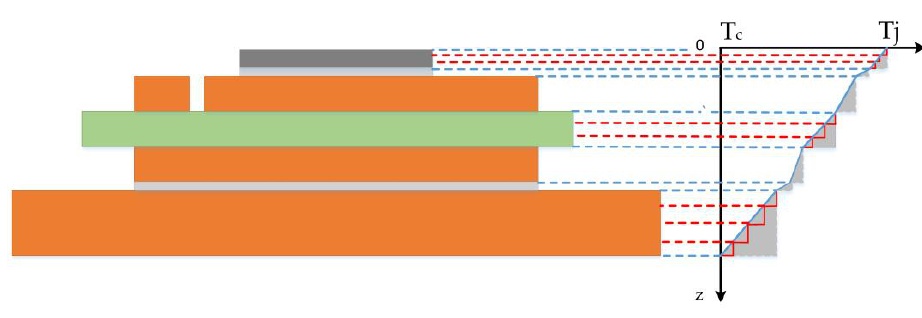
Figure 7. Comparison of two models.